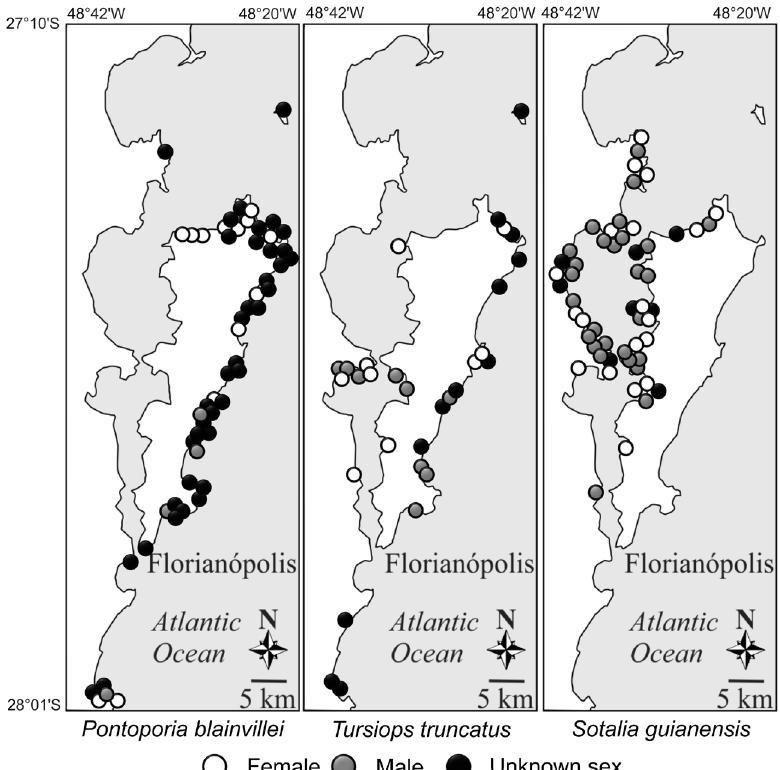
Figure 7. Spatial distribution of strandings of Pontoporia blainvillei , Tursiops truncatus , and Sotalia guianensis in the central region from 1983 to